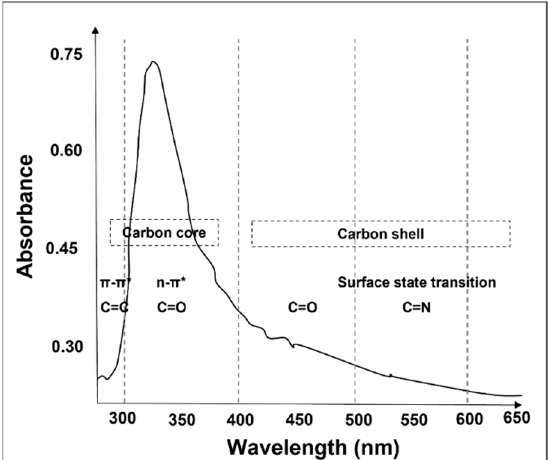
Figure 2. UV–Vis spectra of CDs from Calotropis procera leaves through hydrothermal method at 200 °C for 4 h. Reproduced with copyright permission of Elsevier [73]. Table 4. Summary of the synthesis of CDs from leaves, seeds, and stems.